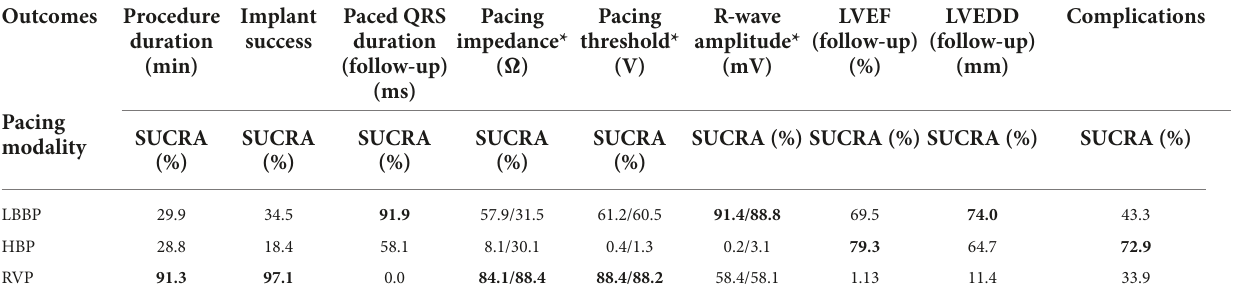
TABLE 4 Relative rankings of HBP, LBBP, and RVP based on SUCRA values (*after implantation/at follow-up).